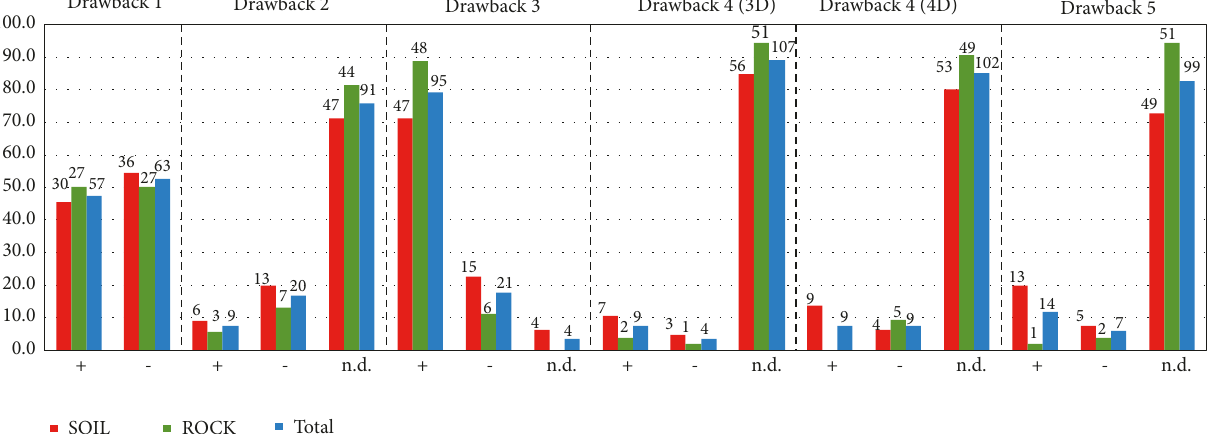
Figure 3: The bar graph indicates the percentage of efforts made (+ means many/some, - means insufficient, and n.d. means nondiscussed) to overcome each drawback. The percentages of papers focused on “soil” landslides are in red, those of papers focused on “rock” landslides are in green, while in blue are the total percentages. The numbers on the top of each bar indicate the numbers of